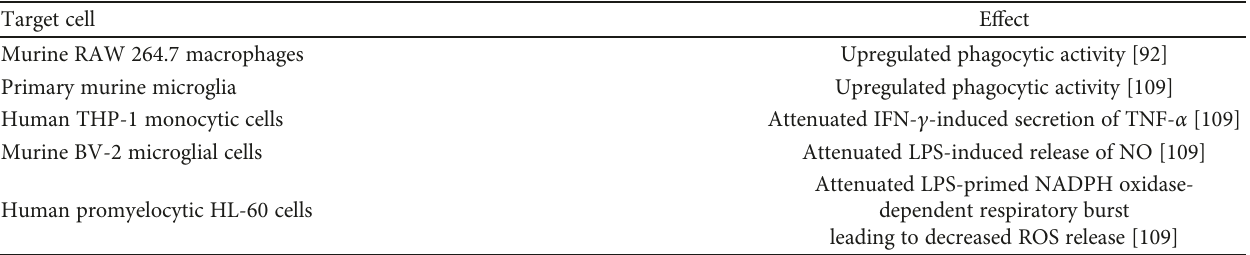
Table 3: E ff ects of extracellular cardiolipin on di ff erent cell